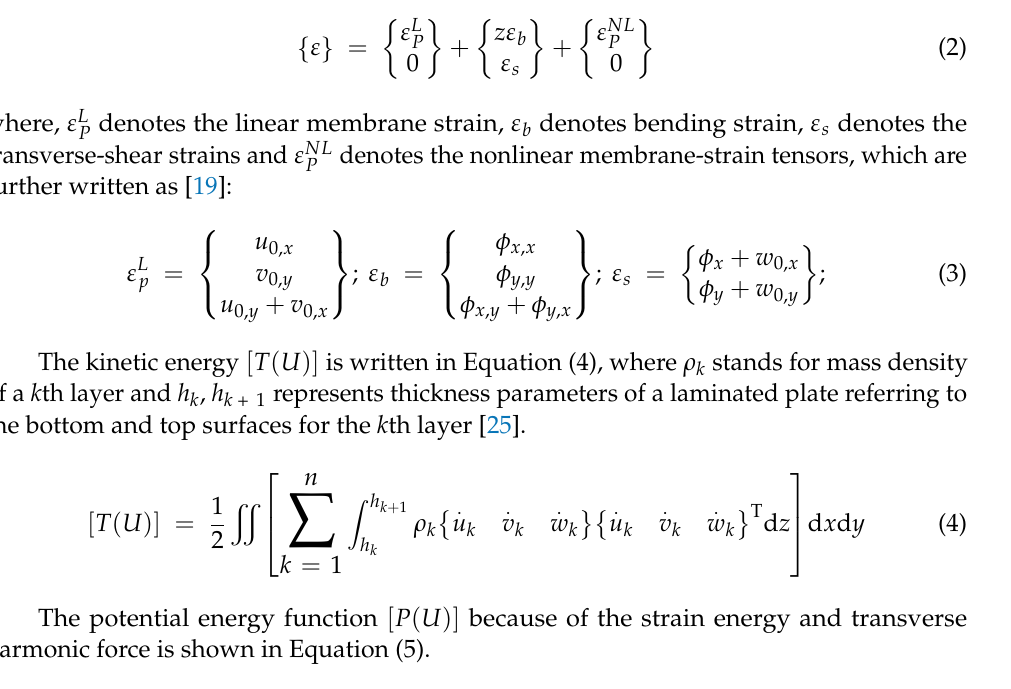
Figure 1. ( a ) Geometric coordinates of the laminated plate; ( b ) Fiber direction for the kth Lamina. Based on von Karman’s assumption, the strain field in terms of the reference plane may be represented as follows [19]: